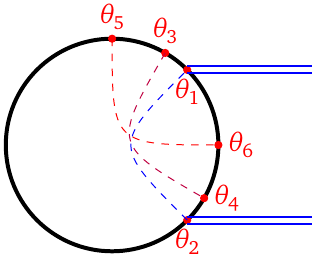
Figure 4: The 2-fold Schwinger-Keldysh contour for six-point OTOC